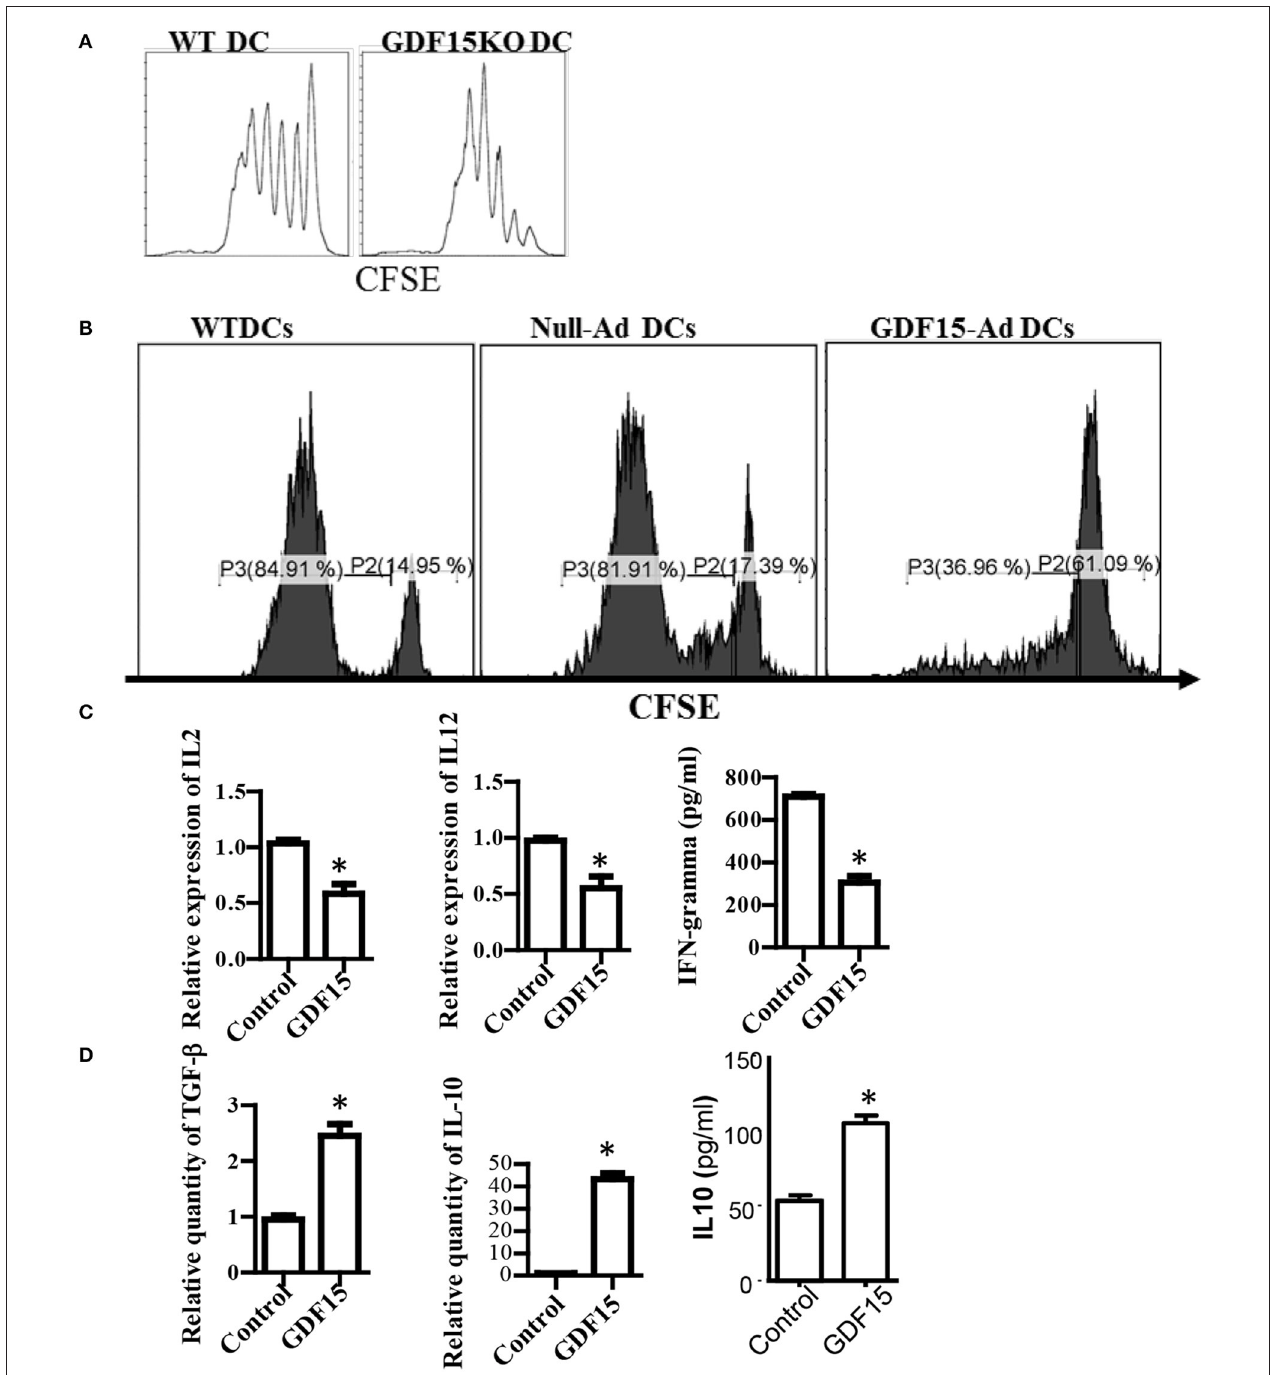
FIGURE 3 | GDF15 impaired DC’s capacity to activate T cells. (A) GDF15 KO DCs increased T cell proliferation. BM-derived DCs were cultured from WT or GDF15 KO mice . On day 6, an MLR was performed in which different cultured DCs were used as stimulators and allogeneic (BALB/c) CFSE-labeled T cells were used as responders. Proliferation was measured by CFSE dilution. Data were representatives of n = 3. (B) GDF15-Ad DCs inhibited T cell proliferation. BM-derived DCs were infected with GDF15-Ad on day 2 and an MLR was conducted to measure T cell proliferation . Data were representatives of n = 4. (C) GDF15 decreased the expression of proinflammatory genes. RNA was extracted from DCs treated with GDF15–Ad or Null-Ad. Expression of IL2 and IL-12 was detected by qRT-PCR and IFN γ in the culture medium was detected by ELISA. n = 3, the student T -test was conducted for statistical analysis. (D) GDF15 increased immunosuppressive cytokines IL10 and TGF- β . The expression of TGF- β and IL10 in the cells was detected by qRT-PCR and expression of IL10 in culture medium was detected by ELISA. n = 3, the student T -test was conducted for statistical analysis. * p < 0.05.